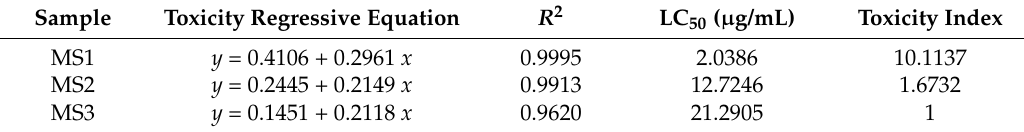
Table 2. Indoor toxicity of azoxystrobin microspheres against Colletotrichum higginsianum